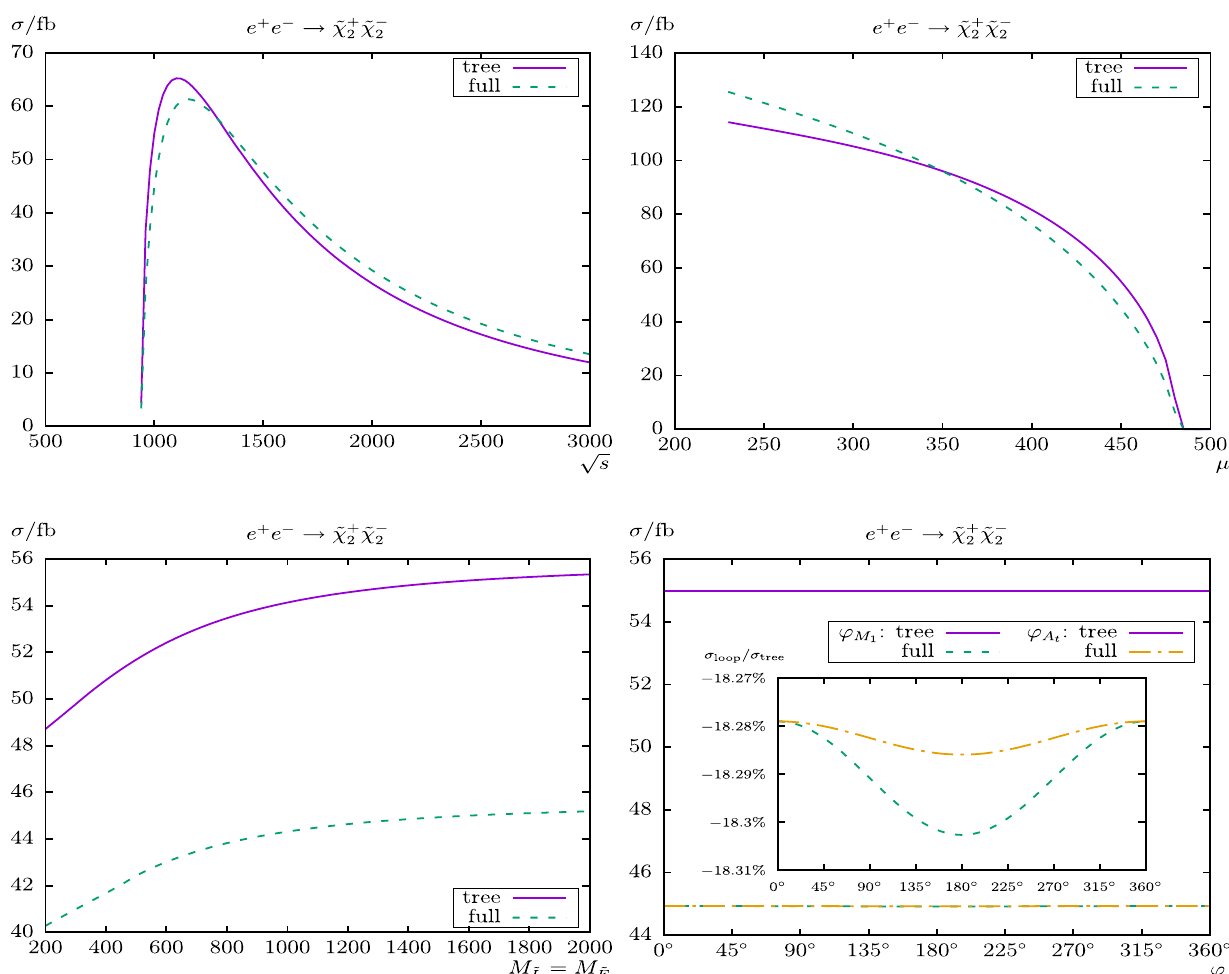
˜ χ − ) . Tree-level and full one-loop corrected cross sections are shown with parameters chosen according to S ; see Table 2. √ 2 2 s (left) and μ (right) varied; the lower plots show M ˜